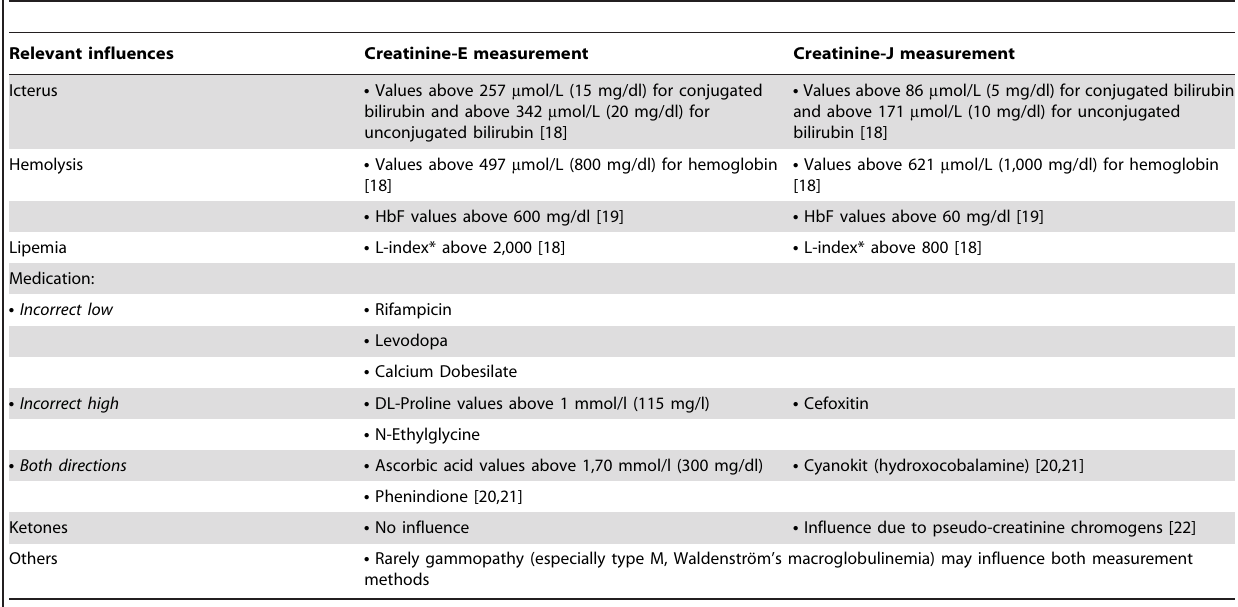
Table 4. Relevant confounders that limit creatinine measurement accuracy according to manufacturer’s test manuals for the enzymatic (creatinine-E) and Jaffe´ assay